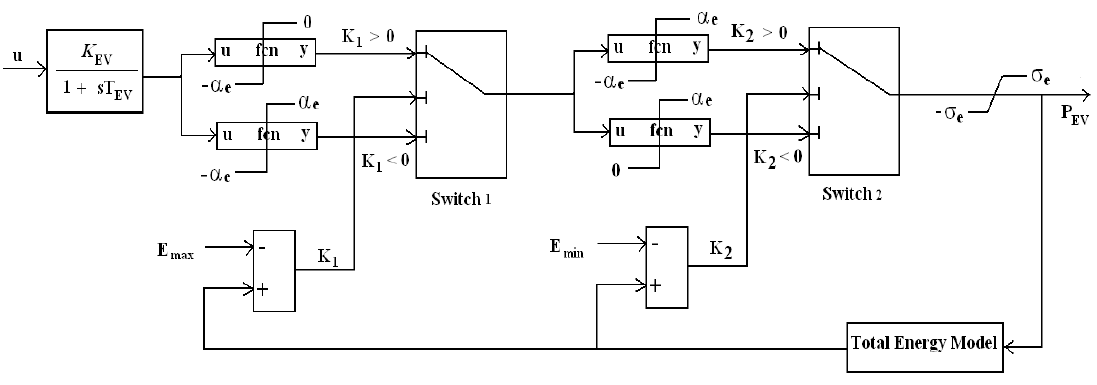
Figure 3. The equivalent EV